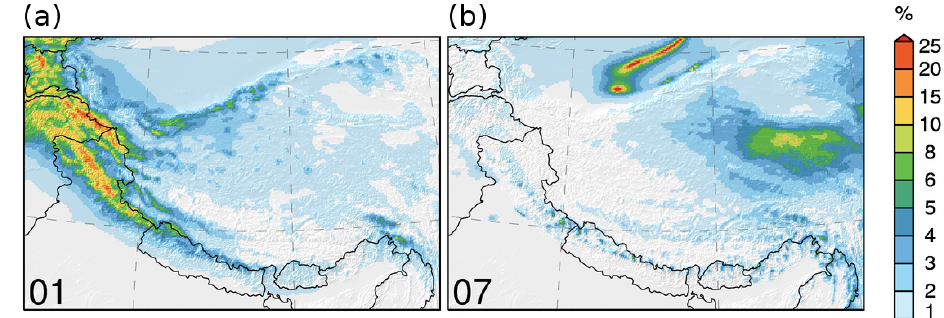
Figure 7. Decadal average of the contribution (%) of cloud particle flux to atmospheric water transport in January (01, (a) ) and July (07, (b) ) for